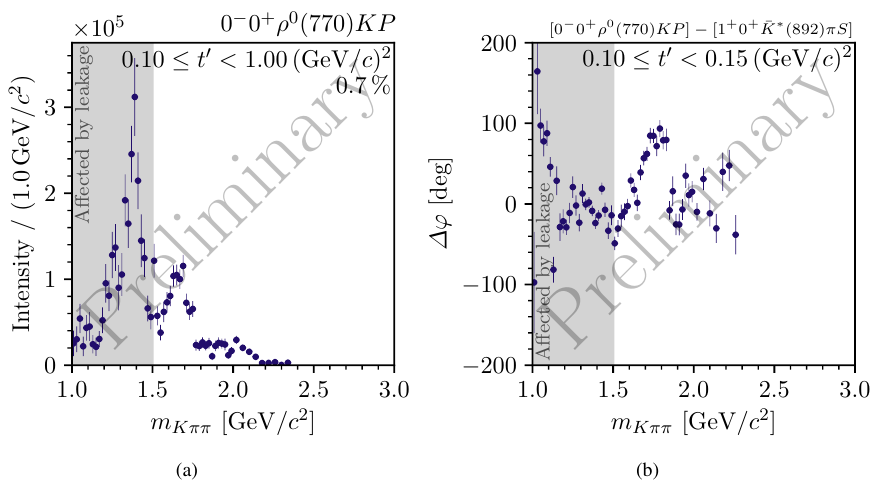
Figure 4: Intensity and relative phase of the 0 − 0 + ρ (770) K P wave. (a) shows the intensity distribution in the range 0 . 1 ≤ t (cid:48) < 1 . 0 (GeV / c ) 2 . (b) shows phase of the 0 − 0 + ρ (770) K P wave with respect to the 1 + 0 + K ∗ (892) π S wave in the lowest analyzed t (cid:48) bin, i.e. in the range 0 . 10 ≤ t (cid:48) < 0 . 15 (GeV / c ) 2 . The percentage number in the upper-right corner of the intensity spectrum is the relative intensity of this